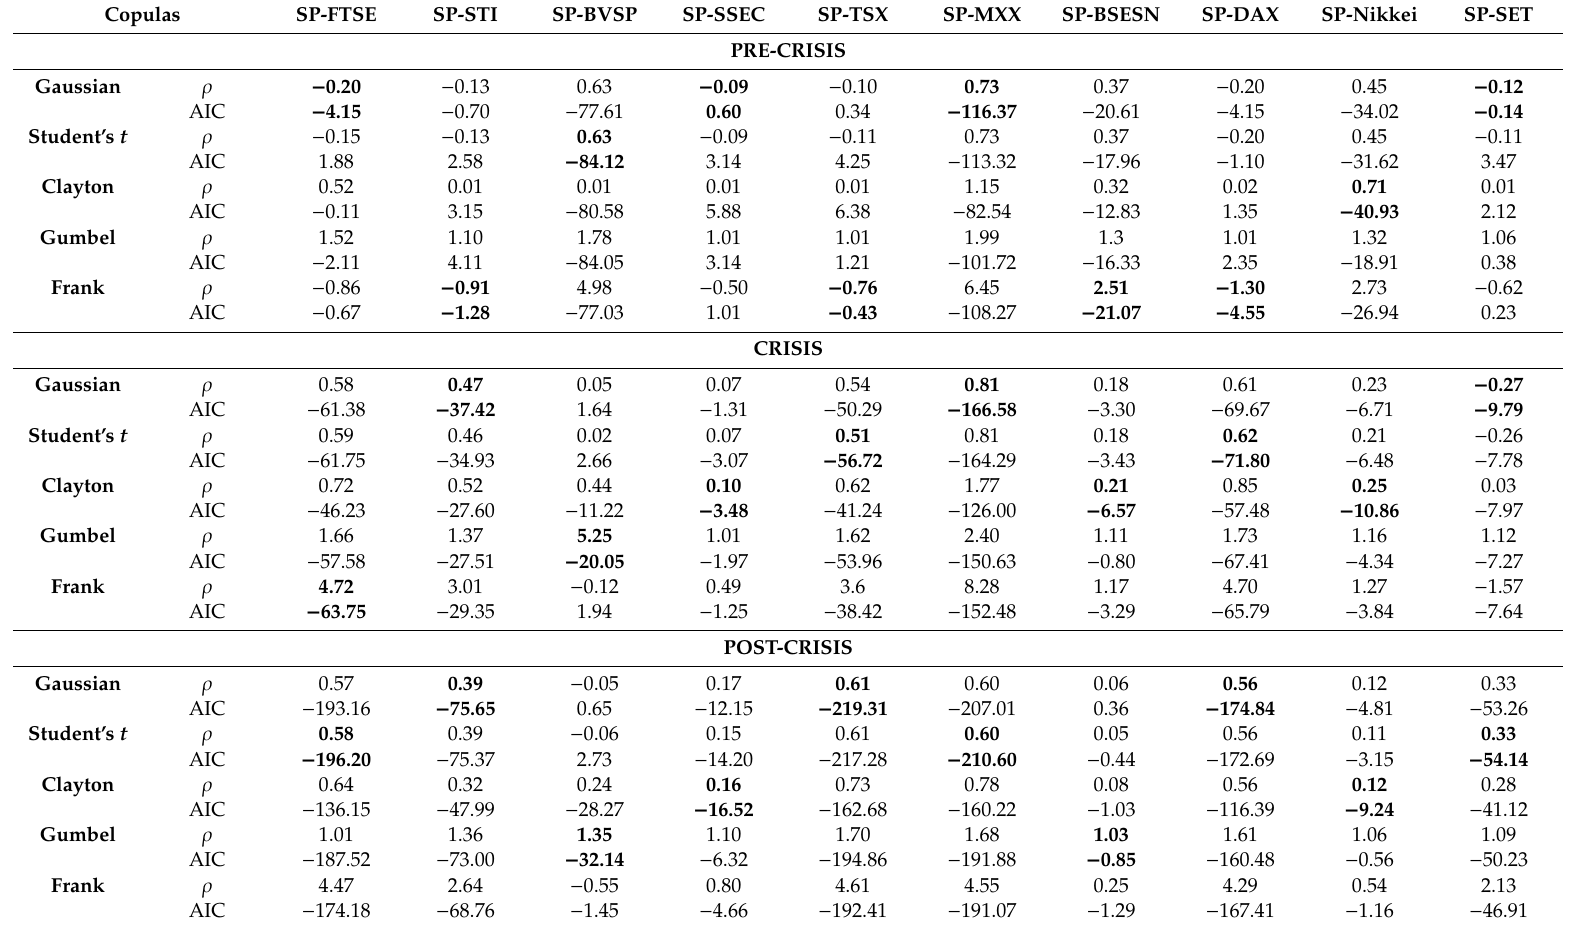
Table 4. Copula estimates of US stock-international stock for pre-crisis, crisis, and